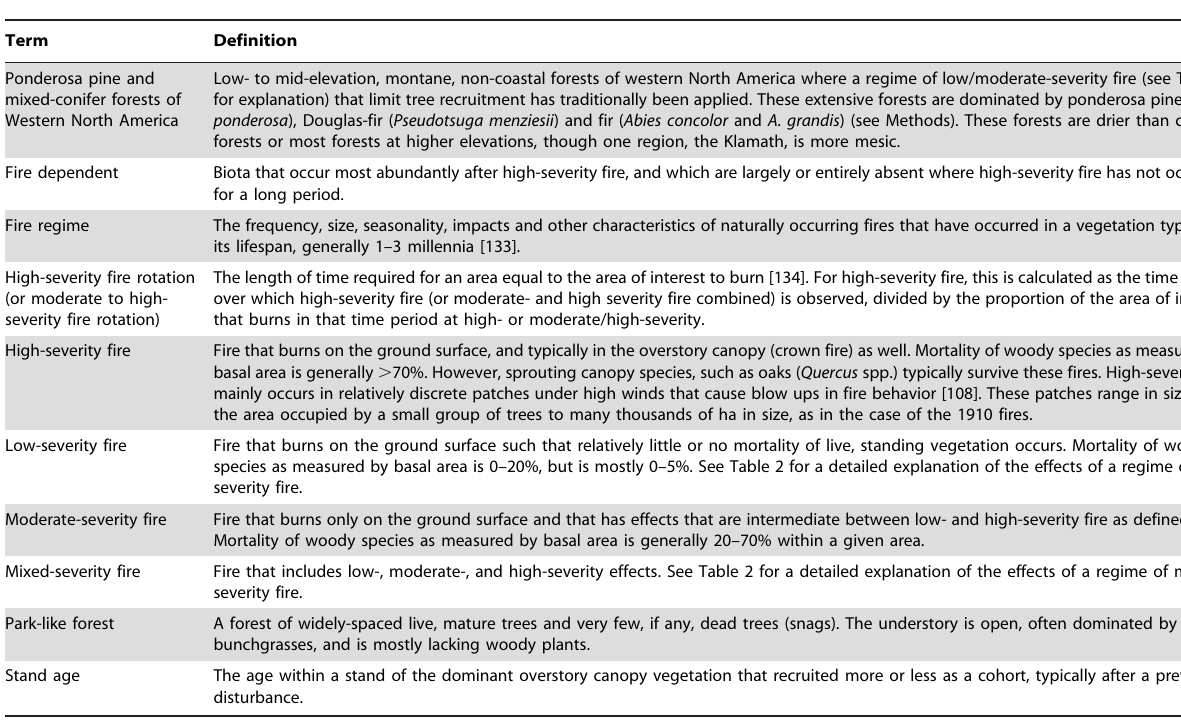
Table 1. Definitions of terms as used in this